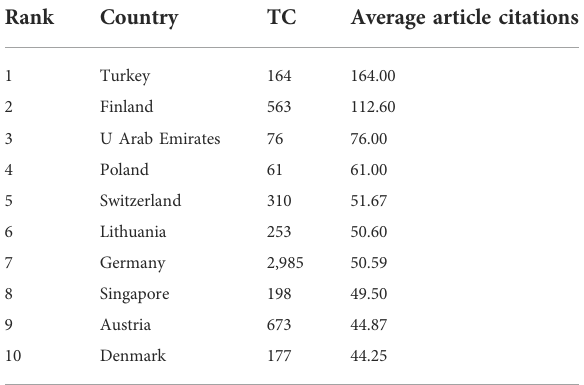
TABLE 2 Top 10 countries with the highest average citations of published articles on TPP biomedical applications. Rank Country